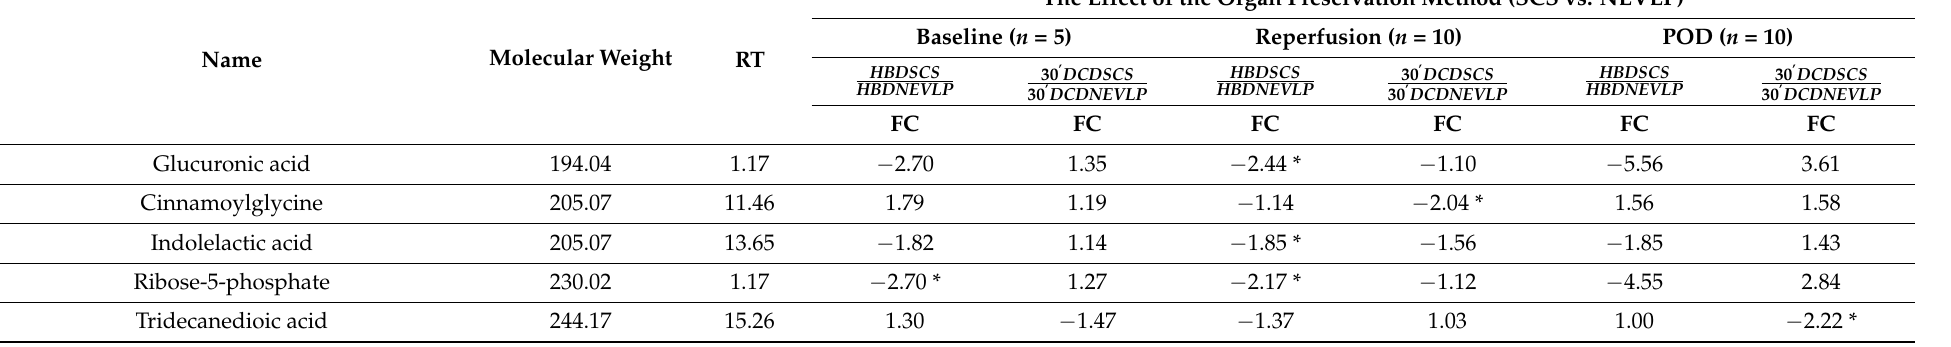
Table 2. Statistically significant compounds identified in SCS- and NEVLP-preserved organs from HBD and 30 (cid:48) DCD donors at particular time points. Data were acquired in negative ionization mode. The Kruskal—Wallis test and multiple (post-hoc) mean-rank comparisons were used to select the metabolites statistically significantly different from the SCS and NEVLP methods. Results are presented as fold